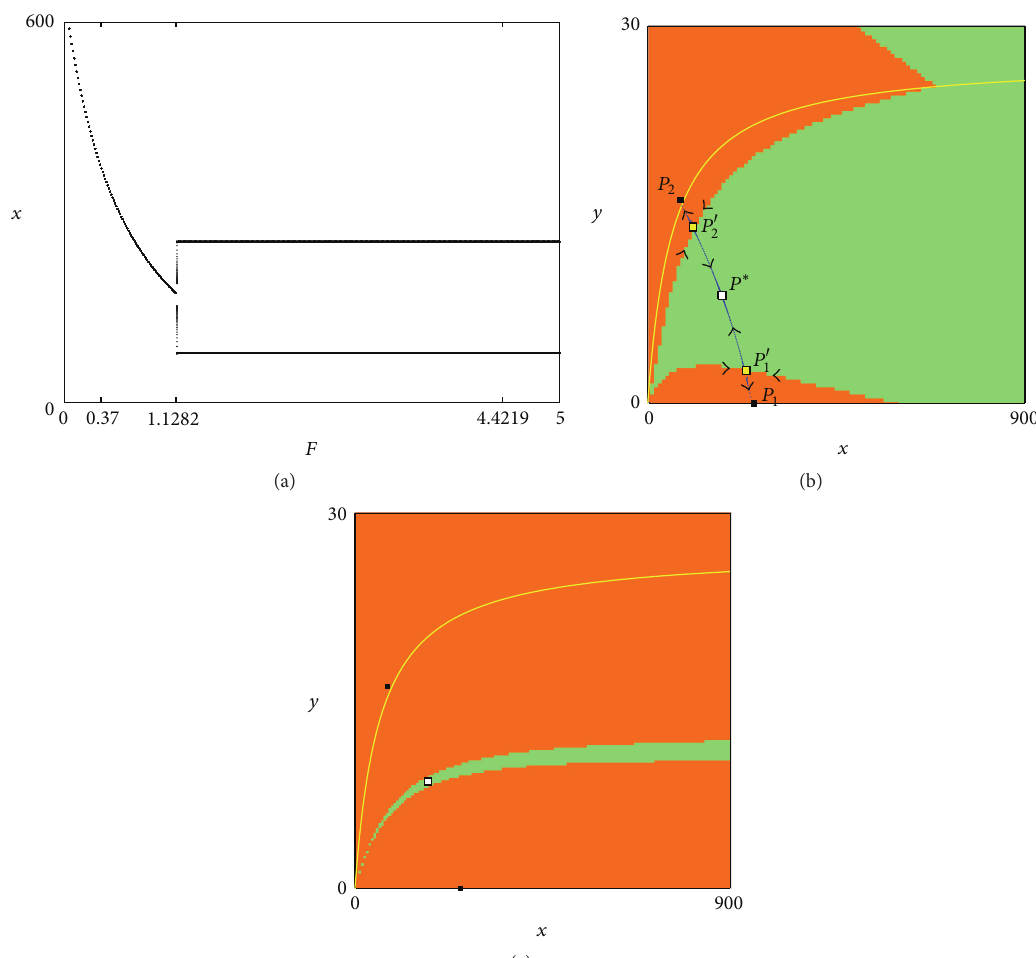
Figure 3: (a) One-dimensional bifurcation diagram for 𝜇 = 0.63 and 𝛿 = 14.6 : for a given initial condition the system converges to 𝑃 ∗ or to 𝐶 2 as 𝐹 is increased. (b) 𝐹 = 1.1 . Before the flip bifurcation at 𝐹 ≃ 1.1282 , 𝑃 ∗ (white point) is locally stable and it coexists with a stable 2-period cycle (black points): their basins are depicted in green and orange, respectively. (c) 𝐹 = 1.128 . Immediately before the flip bifurcation the two coexisting attractors are depicted together with their own